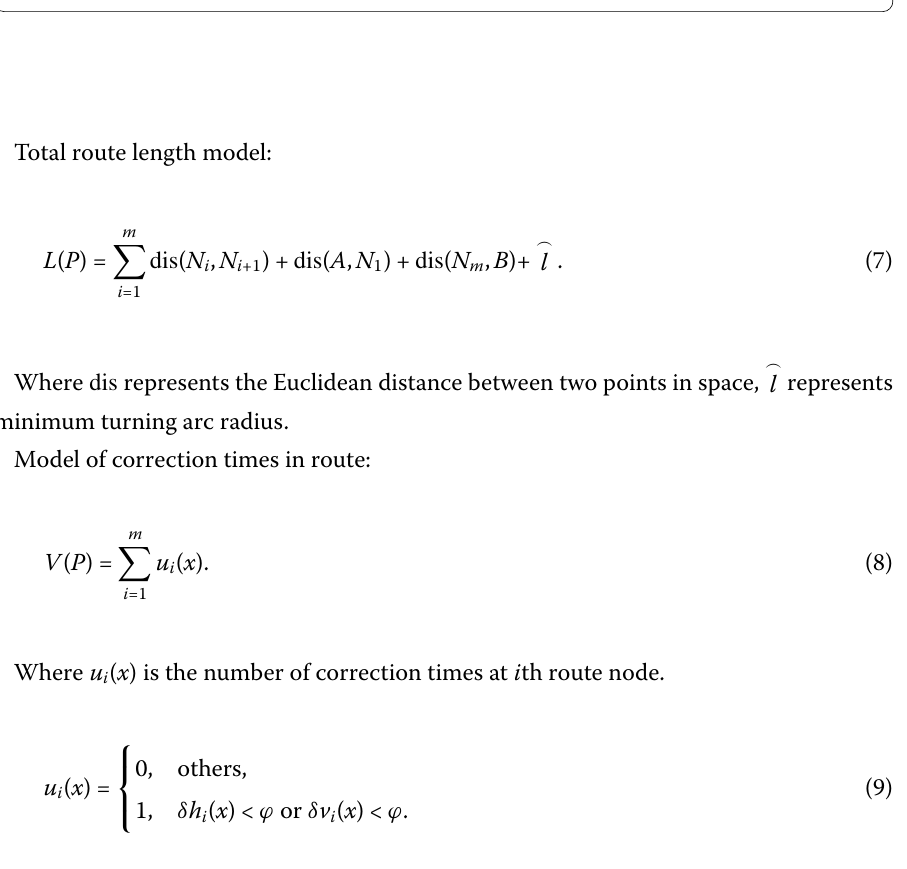
Figure 7 Three-dimensional path analysis